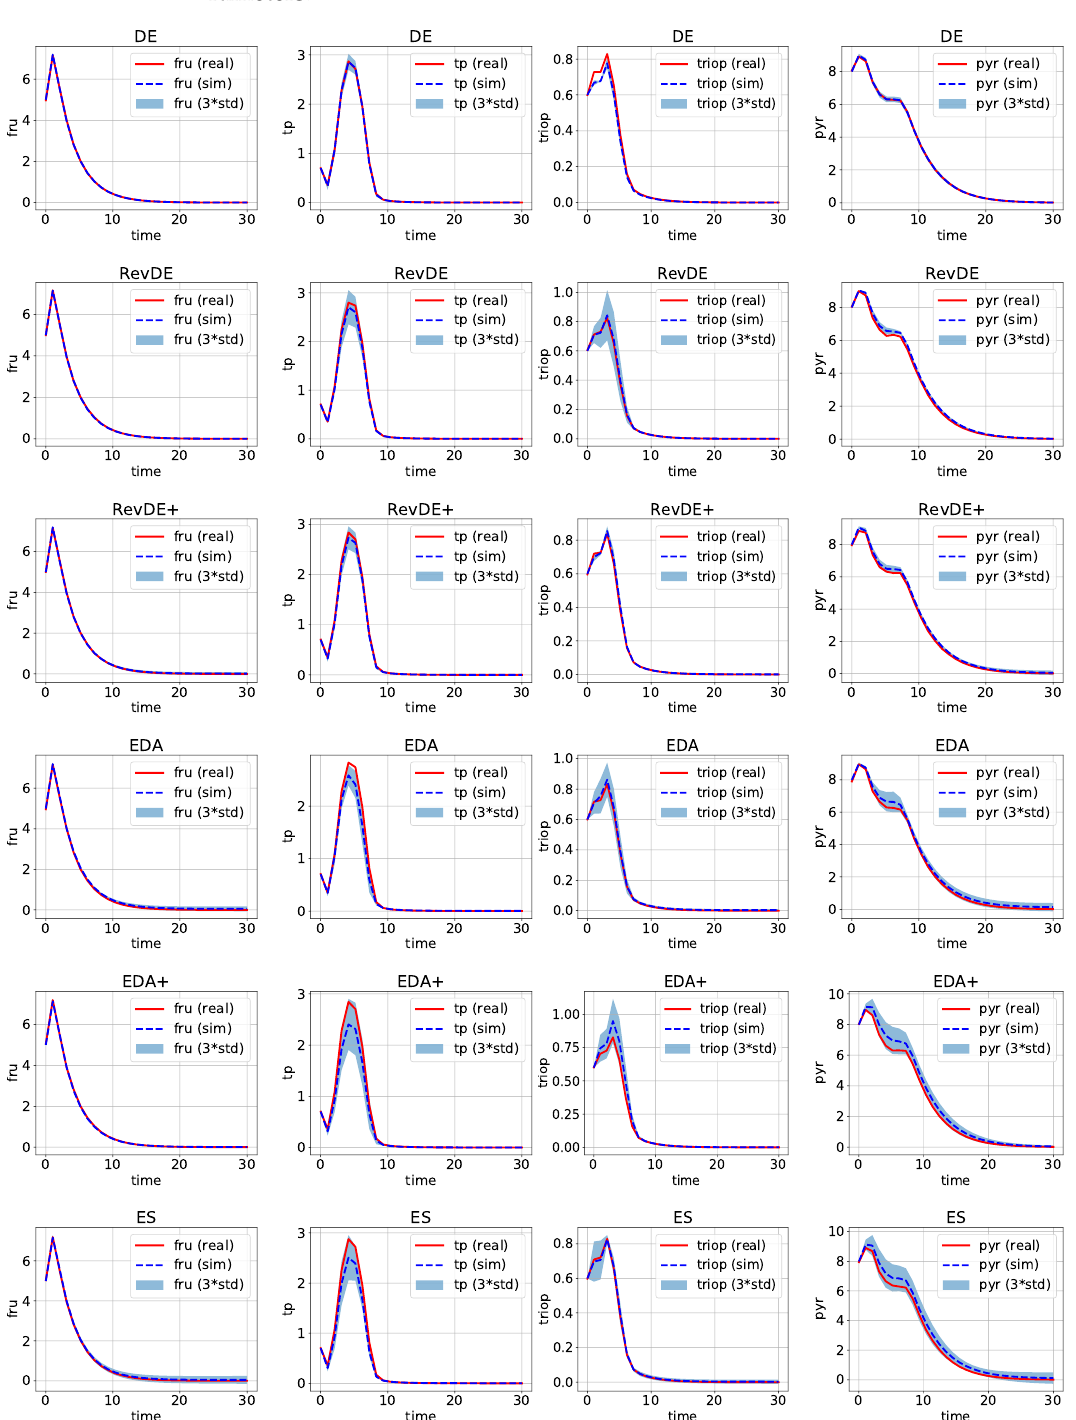
Figure 5. A comparison of the timecourses of the unobserved metabolites. Real timecourses are depicted in red, and the average value and a confidence interval (3 × standard deviation) over 3 runs of the simulator is depicted in blue. The titles of the plots indicate optimization